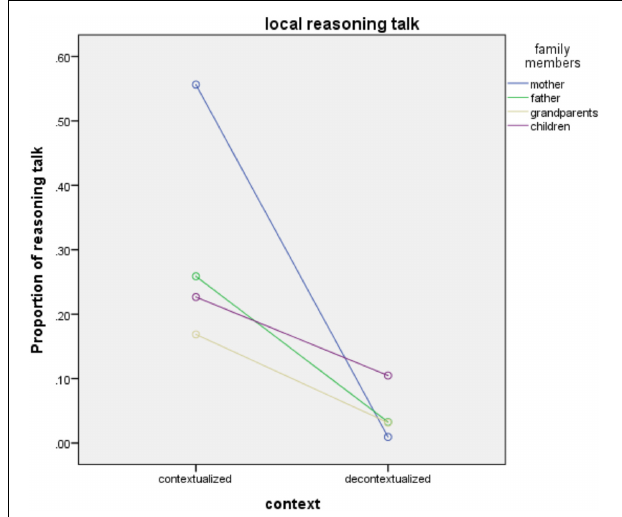
FIGURE 3 | Family members use local reasoning talk in different communicative